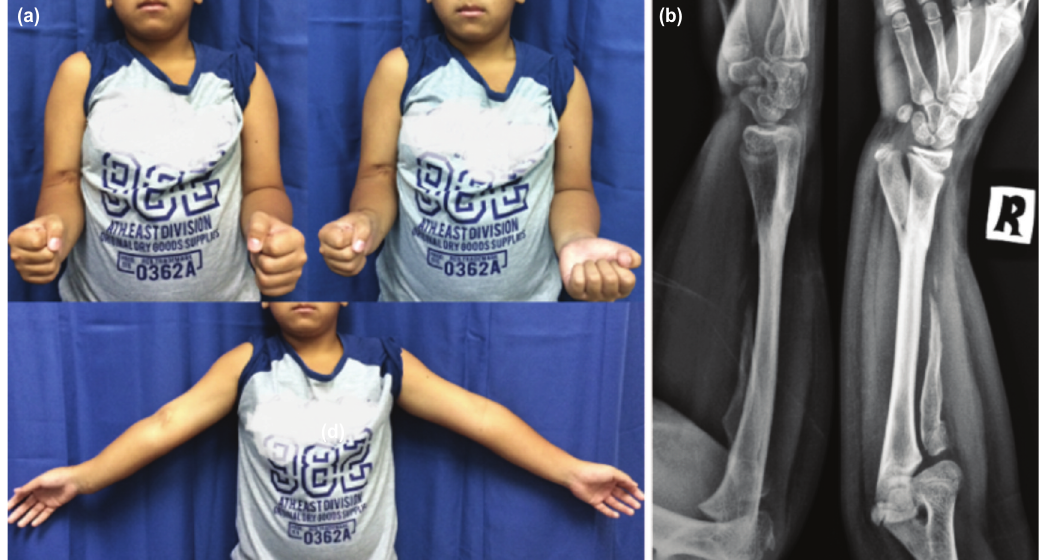
(a) Photographs of the patient at 12 months post-operatively, showing loss of right forearm rotational movement and position Fig. 3: of upper limbs with elbow in extension. (b) Forearm radiograph showing solid union at the fusion